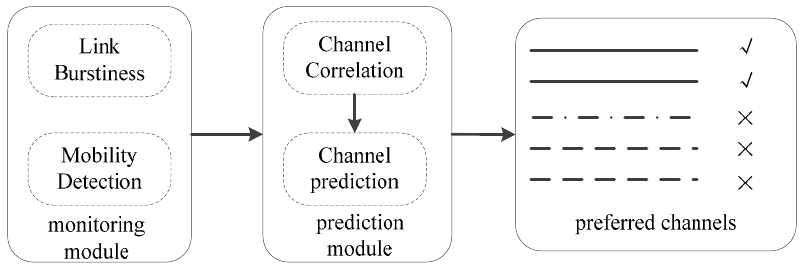
Figure 4. Framework overview.